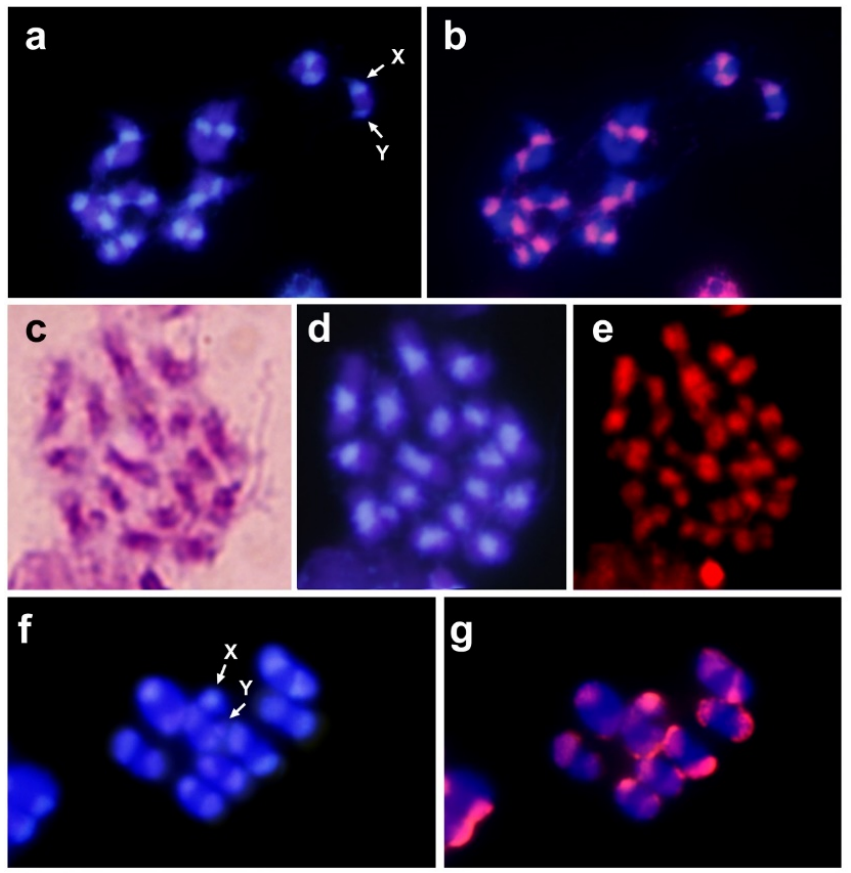
Figure 2. ( a ) Meiotic chromosomes of Chnootriba argus stained with DAPI and subsequently fluorescence in situ hybridization (FISH) with the TTAAAA probe ( b ). Chnootriba argus mitotic metaphase plate stained with Giemsa ( c ), DAPI ( d ) and digested with Tru 9I and stained with ( f ) Meiotic chromosomes of Epilachna paenulata stained with DAPI and subsequently, FISH with the propidium iodide ( e ). ( f ) Meiotic chromosomes of Epilachna paenulata stained with DAPI and TTAAAA probe ( g ). The arrows indicate the sex chromosomes (X and subsequently, FISH with the TTAAAA probe ( g ). The arrows indicate the sex chromosomes (X and y).